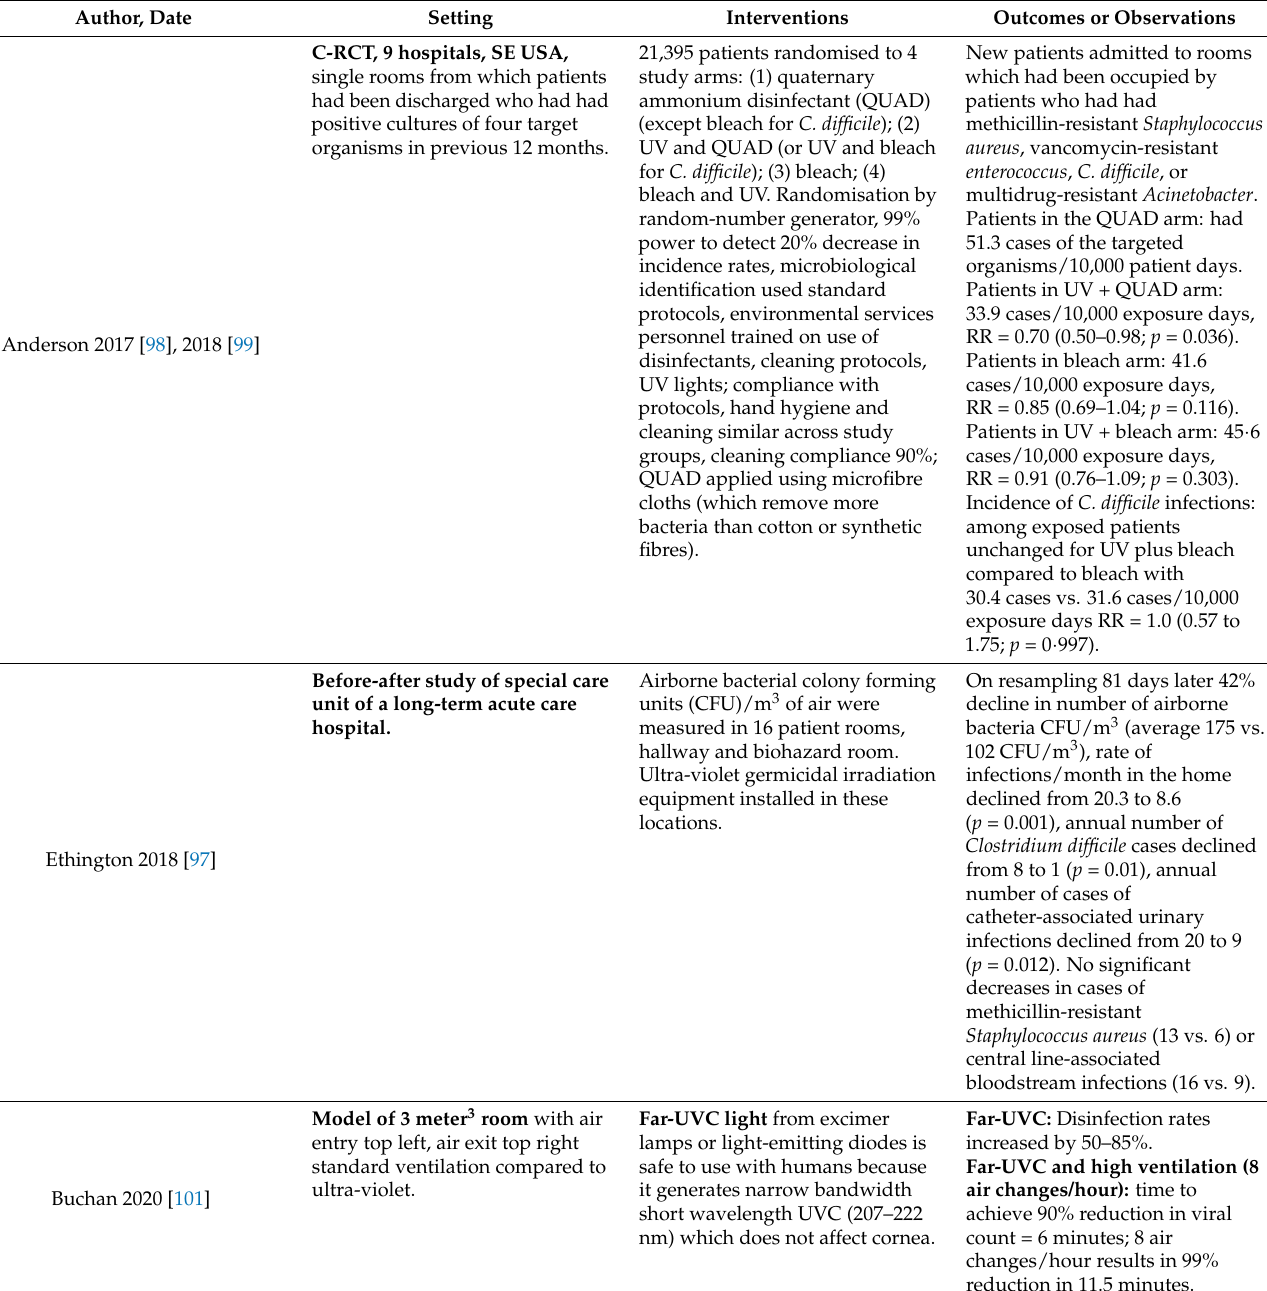
Table 9. UVC lights to decrease surface and air contamination in nursing